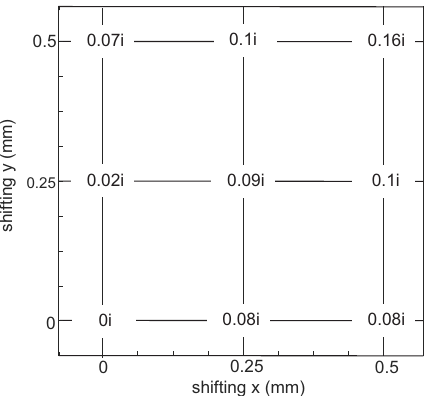
Figure 23. Influence of shifts in the xy plane on the losses.